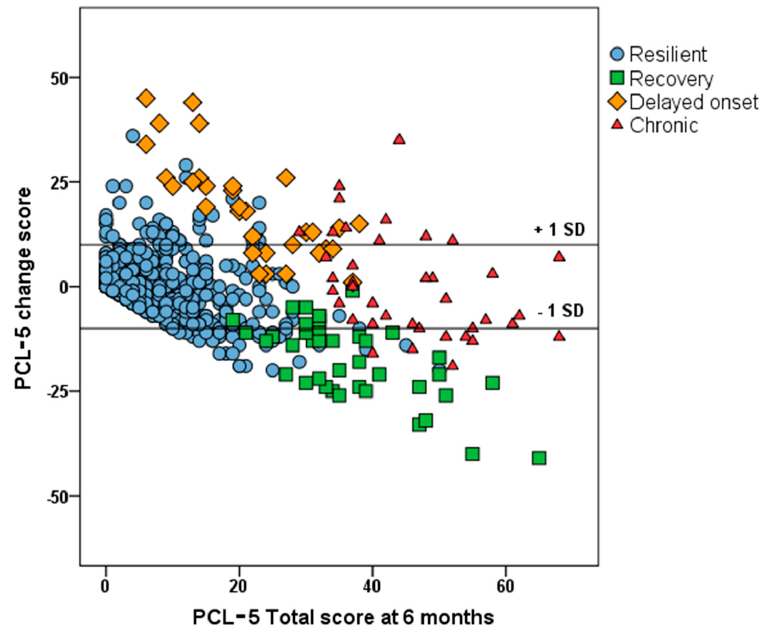
Figure 3. Scatterplot of PCL-5 change scores and PCL-5 total scores 6 months post-injury differenti- ated for PTSD at 6 and 12 months (resilient (83.5%), improved (5.9%), persistent (5.8%) and delayed onset (4.8%)).